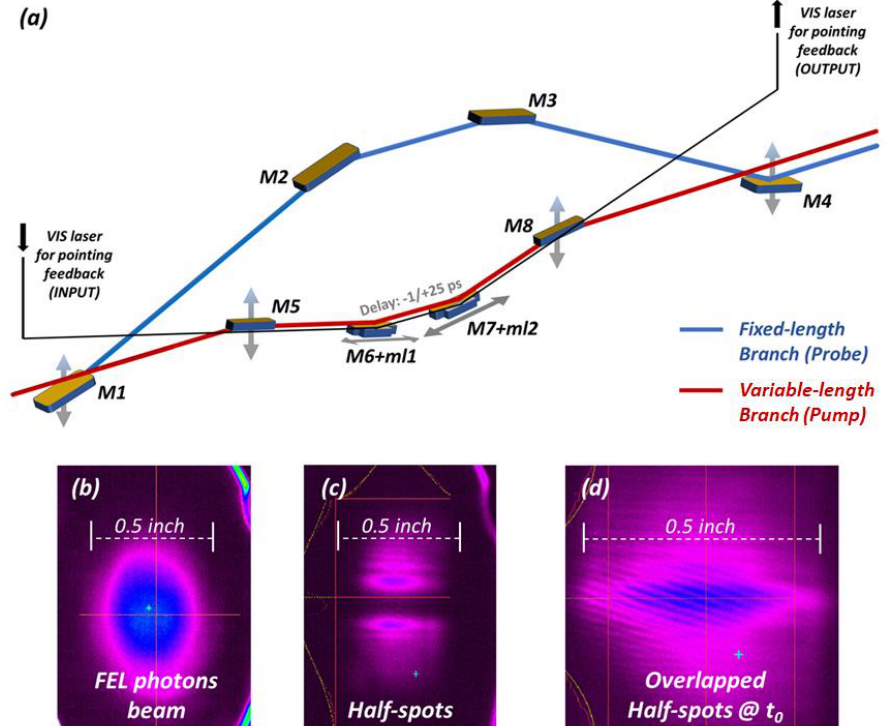
Figure 1. ( a ) Sketch of the AC/DC. Distances, dimensions and mirrors’ incidence angles are reported out of scale for the sake of clearness. The incoming beam is split into two exact half-spots. The pulses reflected by M1 are steered into the (upper) fixed-length optical branch (blue line) and act as probe radiation. Instead, the ones straightly propagating after M1, enter the (lower) variable-length optical branch (red line), and become the pump beam. M6 and M7 can travel in a synchronous way, along a couple of specular mechanical rails to insert the desired temporal delay. The black line refers to the optical laser, which mimics the pump beam trajectory that is used to pick up all instabilities arising during the temporal scan, and thus it acts as a feedback signal to correct any potential misalignment. To do this, the VIS laser beam is reflected by two mirrors (ml1 and ml2) installed alongside M6 and M7; ( b ) the FEL photons beam on a Ce:YAG screen at the far-field without the AC/DC; ( c ) the two FEL half-spots on the same Ce:YAG screen with the AC/DC; ( d ) the two FEL half-spots overlapped in space and time at t 0 , this last one being identified by looking at the appearance of interference fringe.